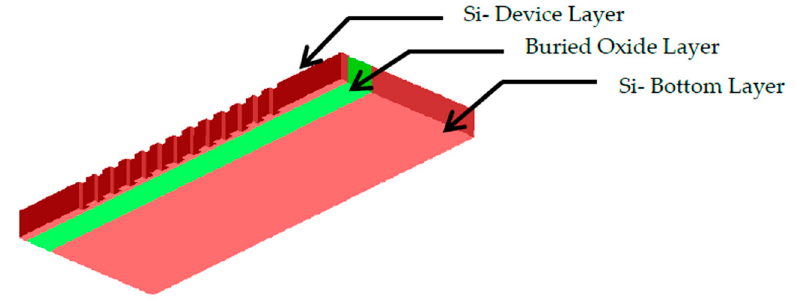
Figure 1. A 3D view of the silicon-on-insulator (SOI) grating structure.